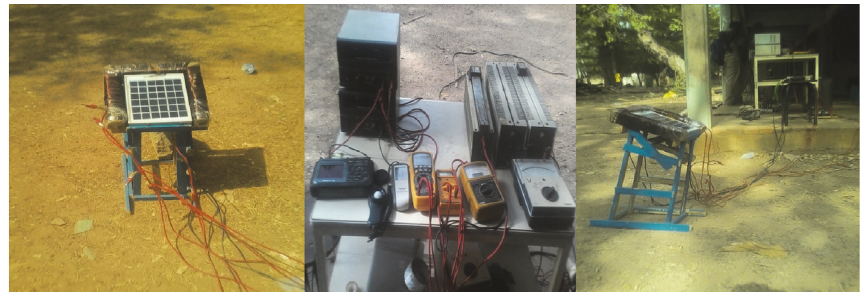
Figure 1: Photography of experimental